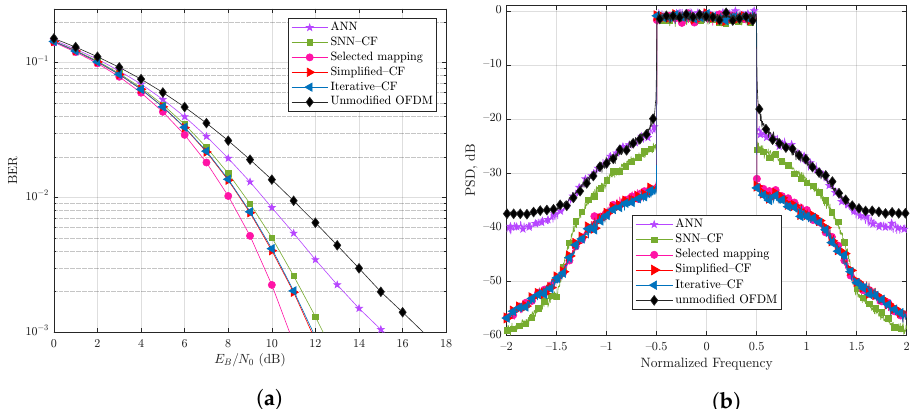
Figure 9. Performance evaluation for 16-QAM-OFDM transmissions deploying non-linear HPA with 3.5 dB input back-off and 6 dB clipping ratio: ( a ) BER; and ( b )